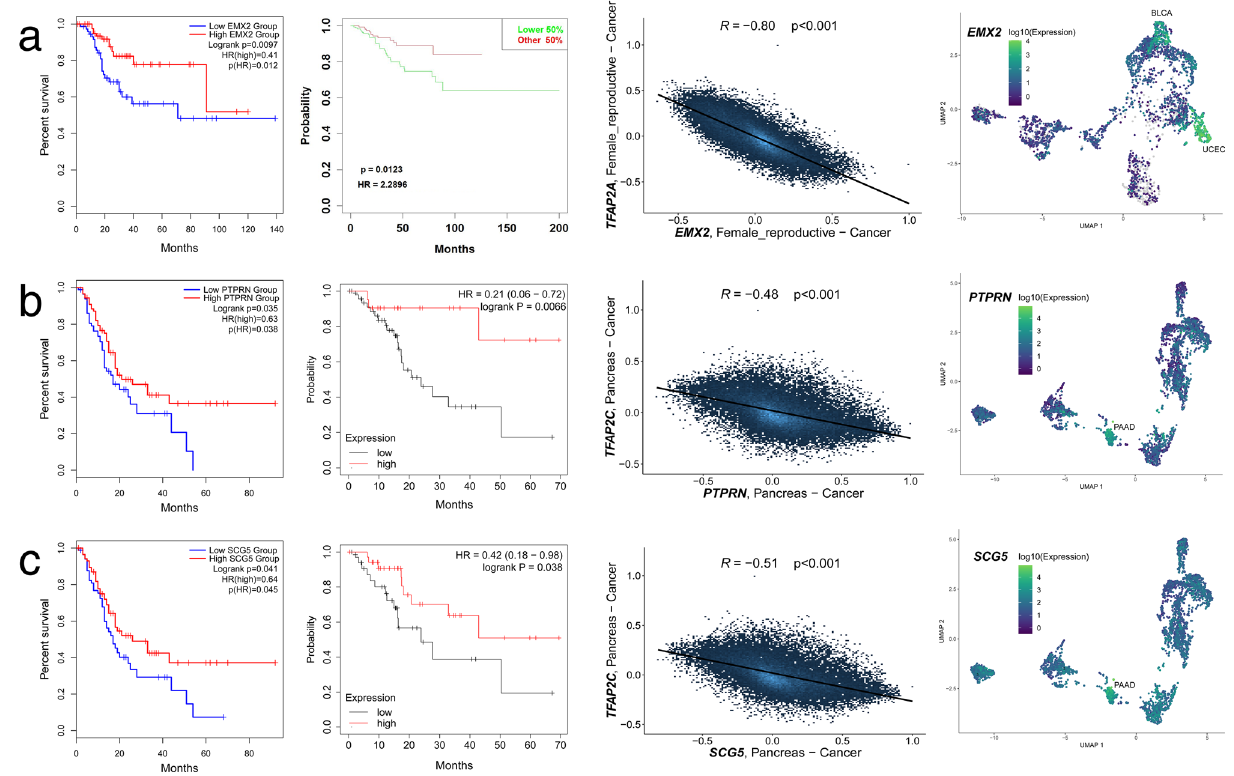
Figure 4. The best three candidate genes from unique targets. ( a ) EMX2 (AP-2α target). ( b ) PTPRN (AP-2γ target). ( c ) SCG5 (AP-2γ target). Each subfigure contains results from survival analysis (left), which was further validated (middle-left). The candidate gene was correlated with AP-2 factor (middle-right) and the specificity of gene expression in tumors was assessed